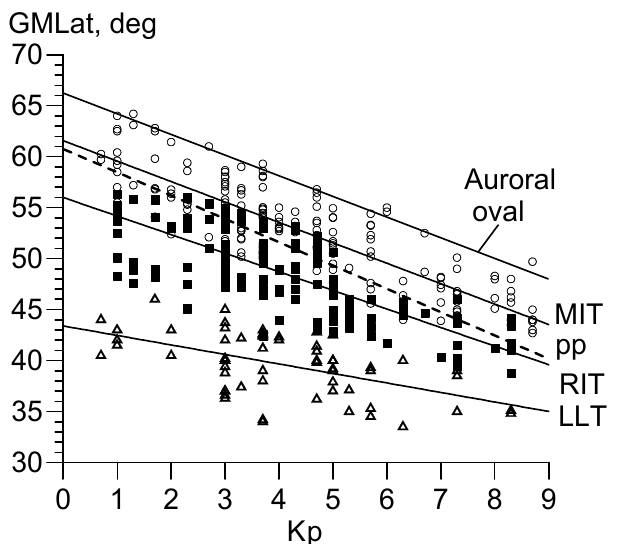
Figure 7. Dependence on the Kp-index the position of the structures, from top to bottom: auroral oval, MIT (circles and approximation line), plasmapause (dashed line), RIT (squares and line), and LLT (triangles and line). The CHAMP data refer to after midnight/morning conditions (00–07 LT).